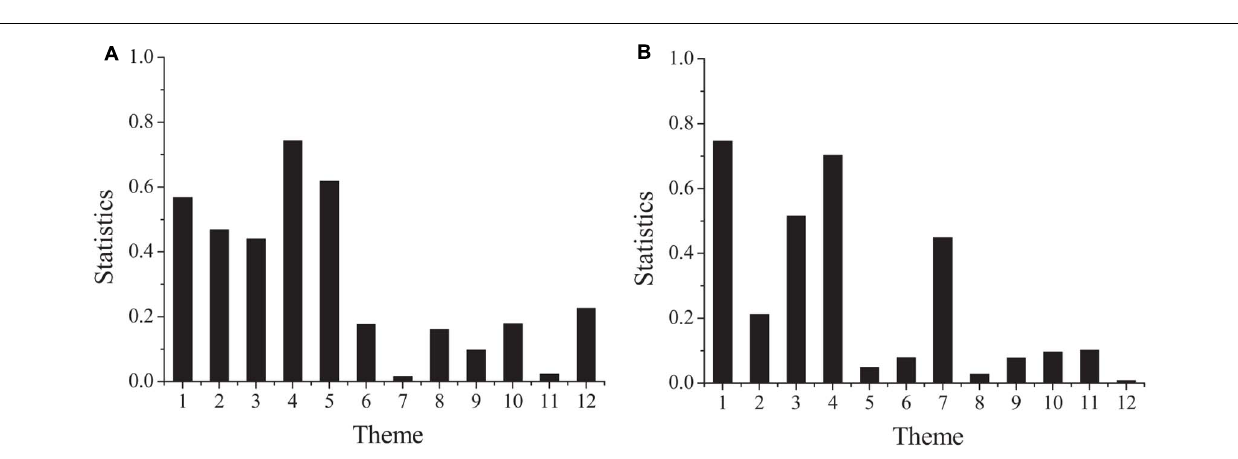
FIGURE 4 | The differences of psychological contract among employees in different positions ( A: the second part; B: the third